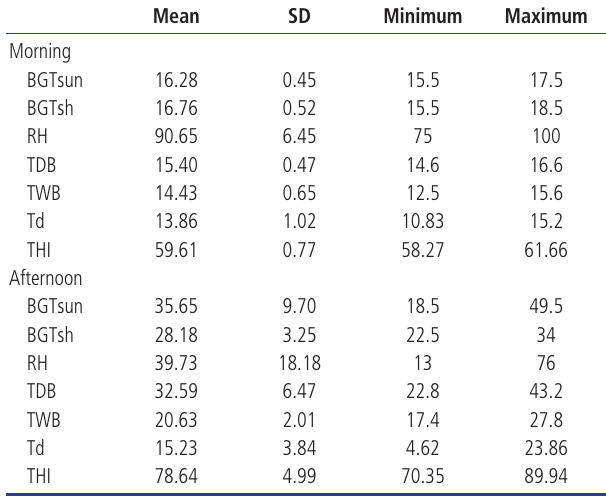
Table 1. Mean, standard deviation (SD) and minimum and maximum of climate measures during the experimental period Mean SD Minimum Maximum Morning